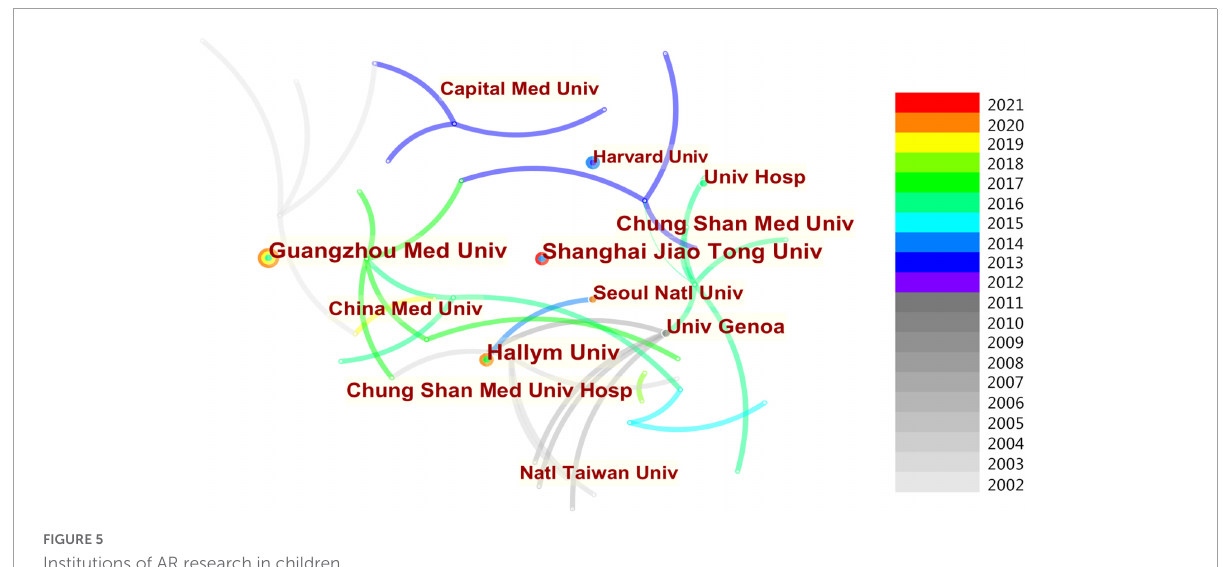
FIGURE5 Institutions of AR research in children.